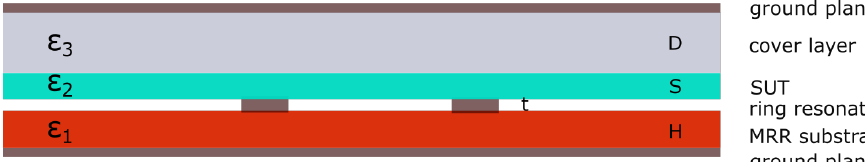
Figure 4. The original MRR configuration as used in